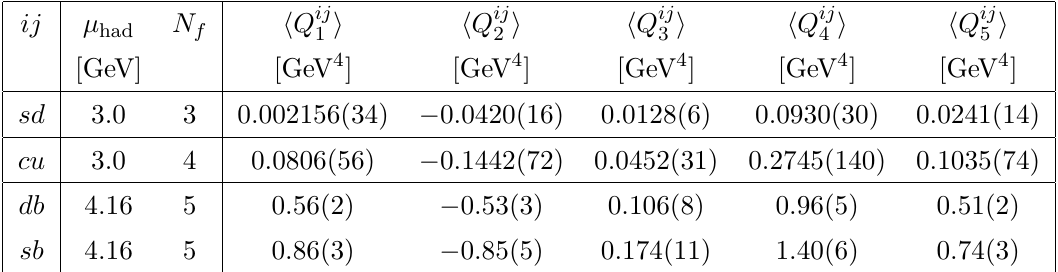
Table 2 . The values of the matrix elements in the SUSY basis in the MS-NDR scheme at the low-energy scale µ had for number of flavours N f